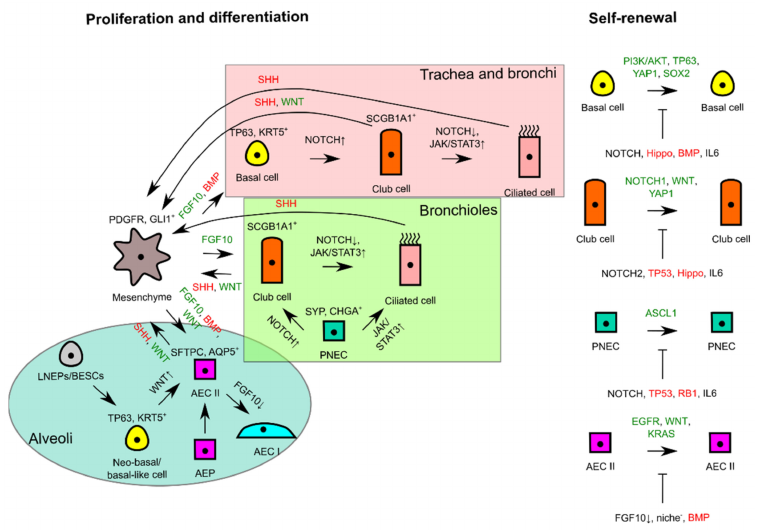
Figure 2. Schematic diagram illustrating self-renewal and the interactions of lung epithelial resi- dents with mesenchyme to trigger proliferation or to maintain tissue quiescence. In the different proximodistal locations of lung epithelia, signaling pathways are used differently for differentiation, whereas similar signals are used for proliferation and lung tissue quiescence in progenitor cells of respective lung tissue locations. FGF10 or WNT from mesenchyme consequently triggers self-renewal of progenitor cells if differentiating and tissue quiescence signals (–|sign) are missing during tissue repair or homeostasis. Green signals favor proliferation, whereas red signals favor tissue quiescence. AEC, alveolar epithelial cell; AEP, alveolar epithelial progenitor; BESC, bronchial epithelial stem cell; LNEP, lineage-negative epithelial progenitor; PNEC, pulmonary neuroendocrine